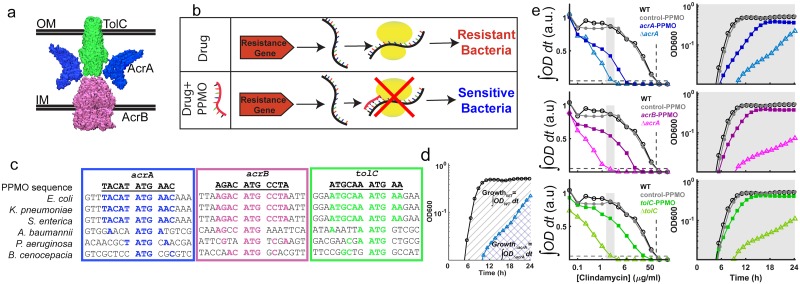
Targeting the genes that encode for the AcrAB-TolC efflux pump complex increases antibiotic susceptibility.(A) Cartoon representation of the AcrAB-TolC efflux system based on available crystal structures (PDB IDs: AcrA-2f1m, AcrB-2dhh, and TolC-1ek9). IM: Inner Membrane; OM: Outer Membrane. (B) PPMOs are antisense molecules that bind to complementary mRNAs and sterically interfere with their translation. Silencing resistance-conferring genes with this strategy leads to antibiotic susceptibility. (C) We have engineered three separate PPMOs in order to target the acrA (blue), acrB (magenta), and tolC (green) genes. These PPMOs target gene regions that span the start codons of the transcribed mRNA. Alignment of the acrA, acrB, and tolC genes of different bacterial genera demonstrate that the PPMO sequences, designed for E. coli, are also complementary in other pathogens. The overlapping nucleotides between the gene sequences and the PPMOs are highlighted in color. The PPMO sequences are homologous in Klebsiella pneumoniae and Salmonella enterica genes but have limited homology to the remaining bacterial species. (D) Growth of bacteria is quantified by calculating the area under the curve (AUC), which is simply integrating OD600 from 0 to 24 h (Materials and Methods). Area under the black (circles) and cyan lines (triangles) correspond to the growth of the wild type and acrA deletion E. coli strains, respectively, in a subinhibitory dose of clindamycin. (E) (Left) Dose response curves as a function of clindamycin concentration. Dose response curves are generated using the AUC values. Curves are labeled as untreated wild type E. coli (black lines, empty circles), with 10 μM control-PPMO (grey lines, filled circles), with 10 μM acrA-PPMO (top panel, blue lines, filled squares), E. coli with acrA deletion (top panel, cyan lines, empty triangles), with 10 μM acrB-PPMO (middle panel, magenta lines, filled squares), E. coli with acrB deletion (middle panel, pink lines, empty triangles), with 10 μM tolC-PPMO (bottom panel, dark green lines, filled squares), and E. coli with tolC deletion (bottom panel, light green lines, empty triangles). The horizontal dashed lines represent 95% growth inhibition, while the vertical lines represent the MIC value for WT. (Right) Sample OD600 versus time growth curves at the conditions shown within the grey shaded areas on the dose response curves (Left). Each line is interpolated, integrated and the AUC is normalized to the wild type growth in the absence of clindamycin. Dose response curves and corresponding MIC values for all 11 antibiotics may be found in S4 Fig and S2 Table, respectively.